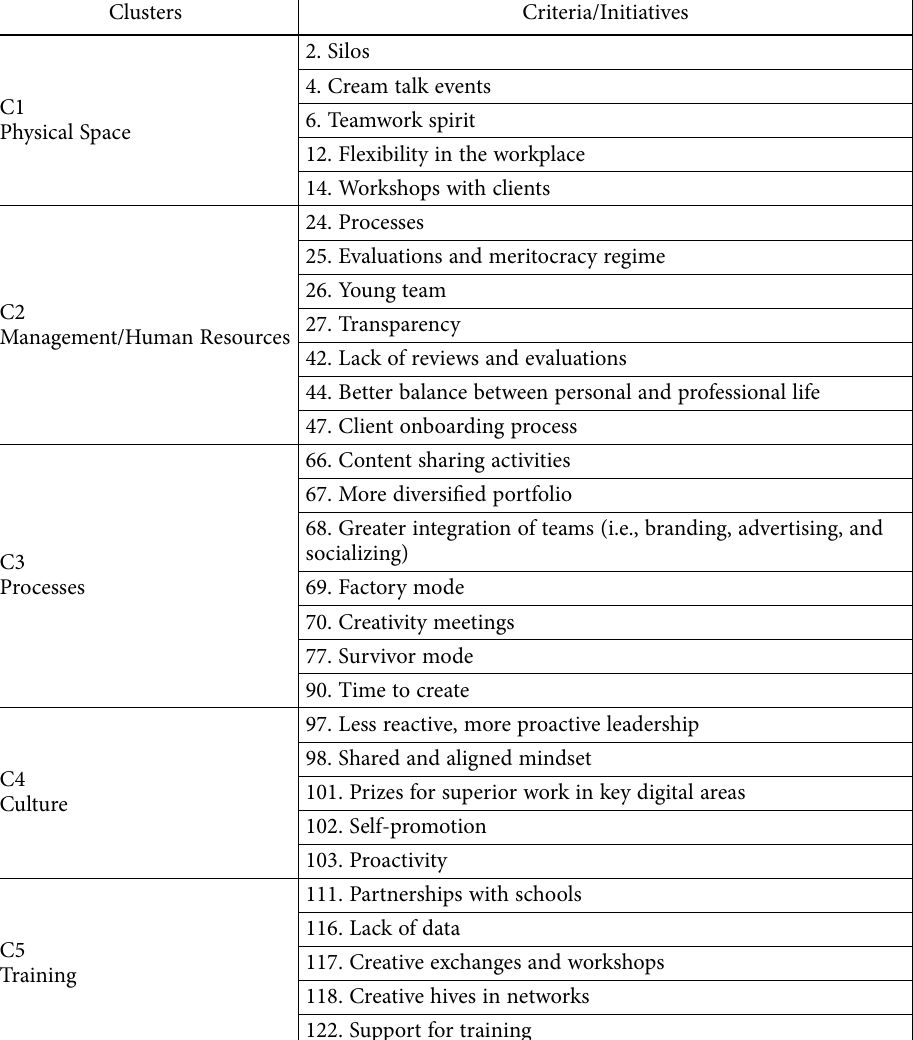
Table 1. Most influential criteria according to decision panel